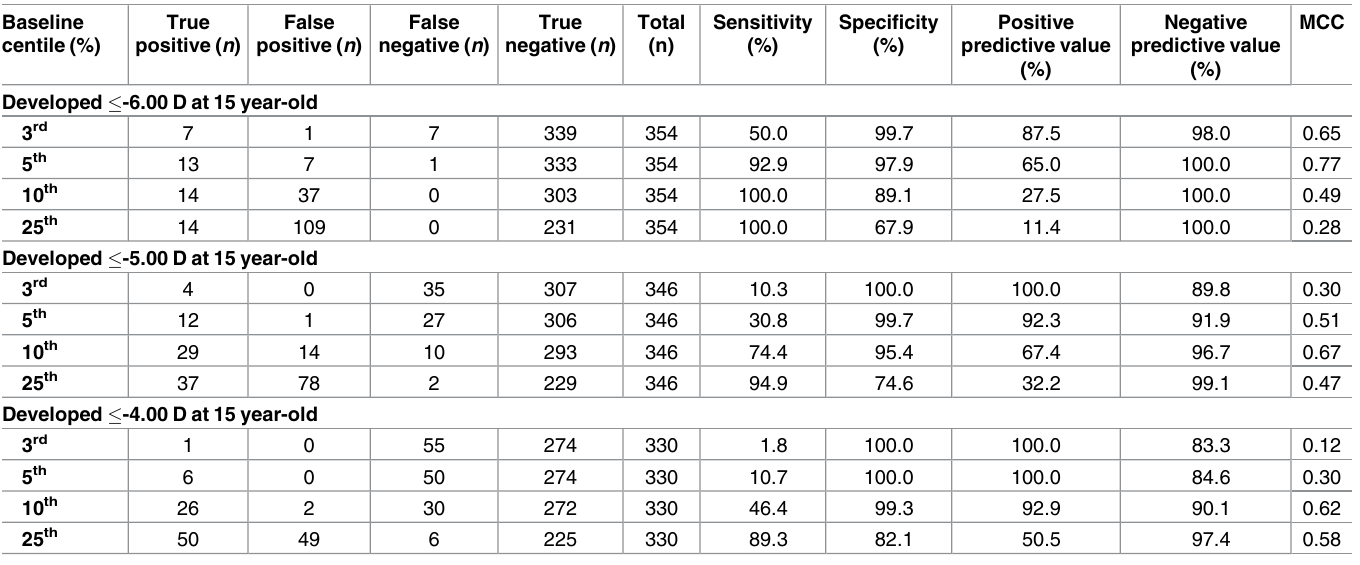
Table 2. The accuracyof baseline centiles to estimaterefractivestatus at the age of 15 yearsin first-born twins * . Baseline centile